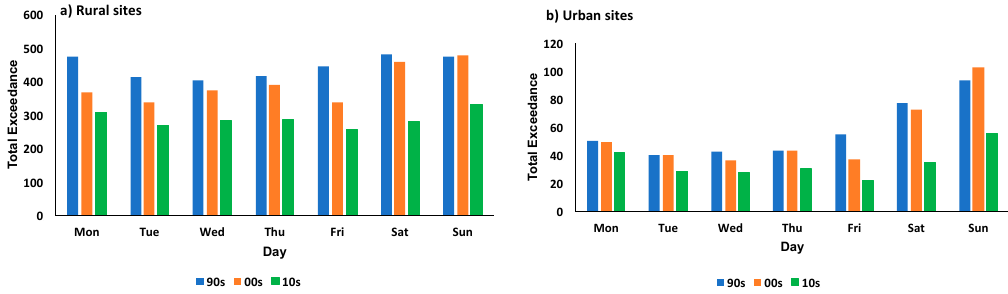
Figure 6. Daily total ozone exceedances in ( a ) rural and ( b ) urban sites averaged for the decades of the 1990s, 2000s and 2010s. Total exceedance is calculated as the total number of hours at an ozone concentration ≥ 50 ppbv for each day in a week, yearly averaged for each decade.